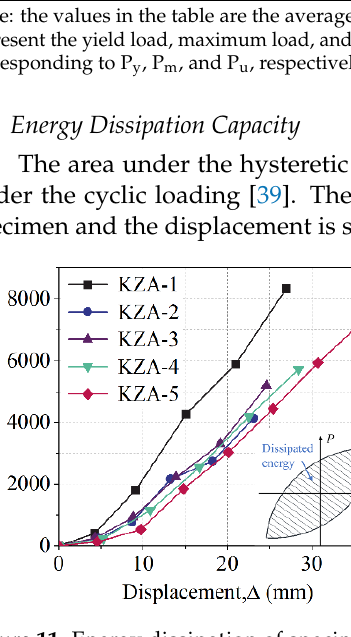
Figure 11. Energy dissipation of specimens.